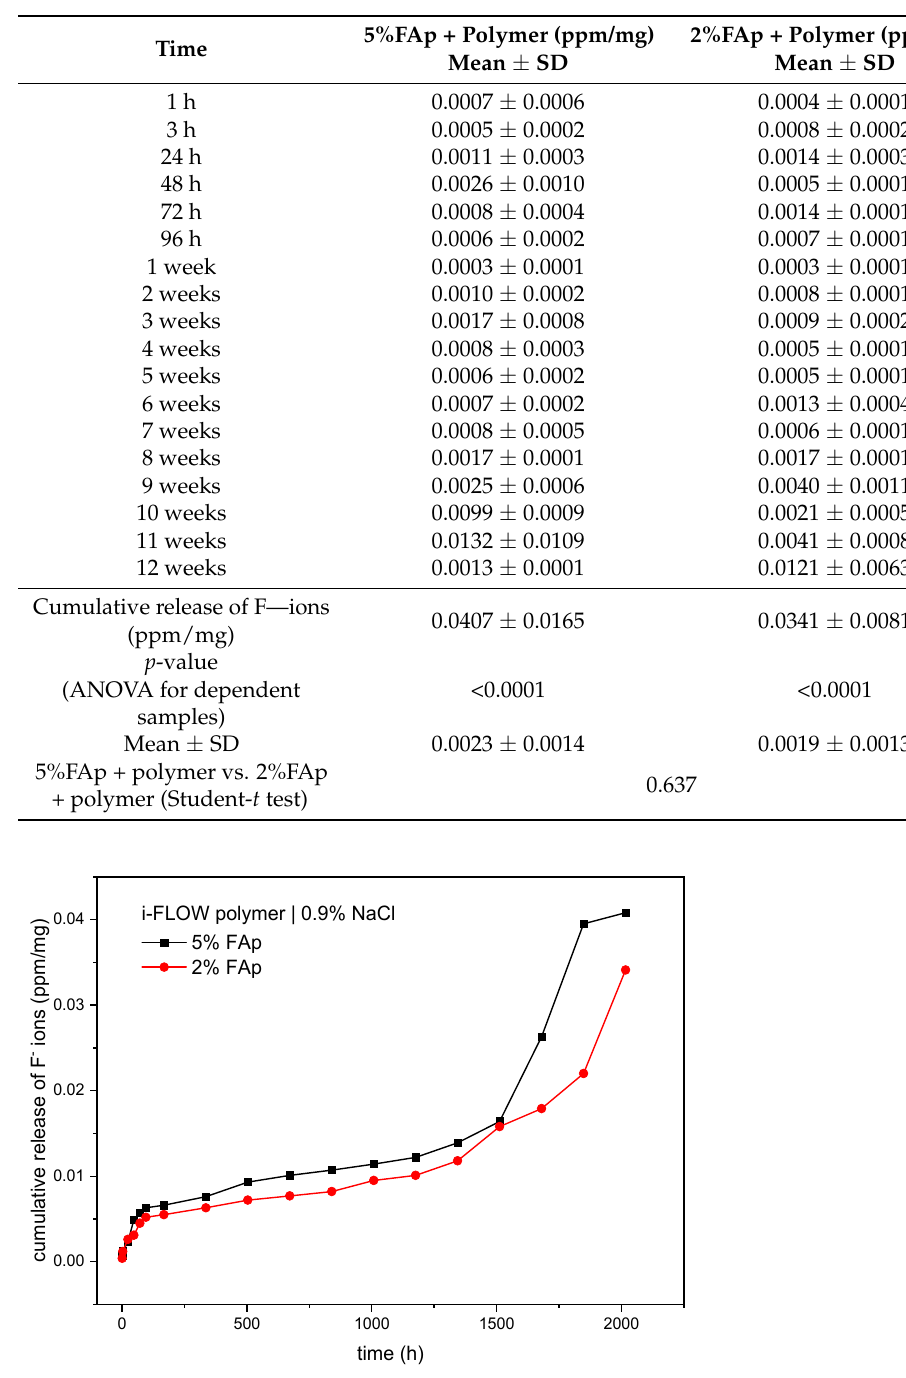
Figure 4. Cumulated release of fluoride ions (ppm/mg) from two study materials into 0.9% NaCl.